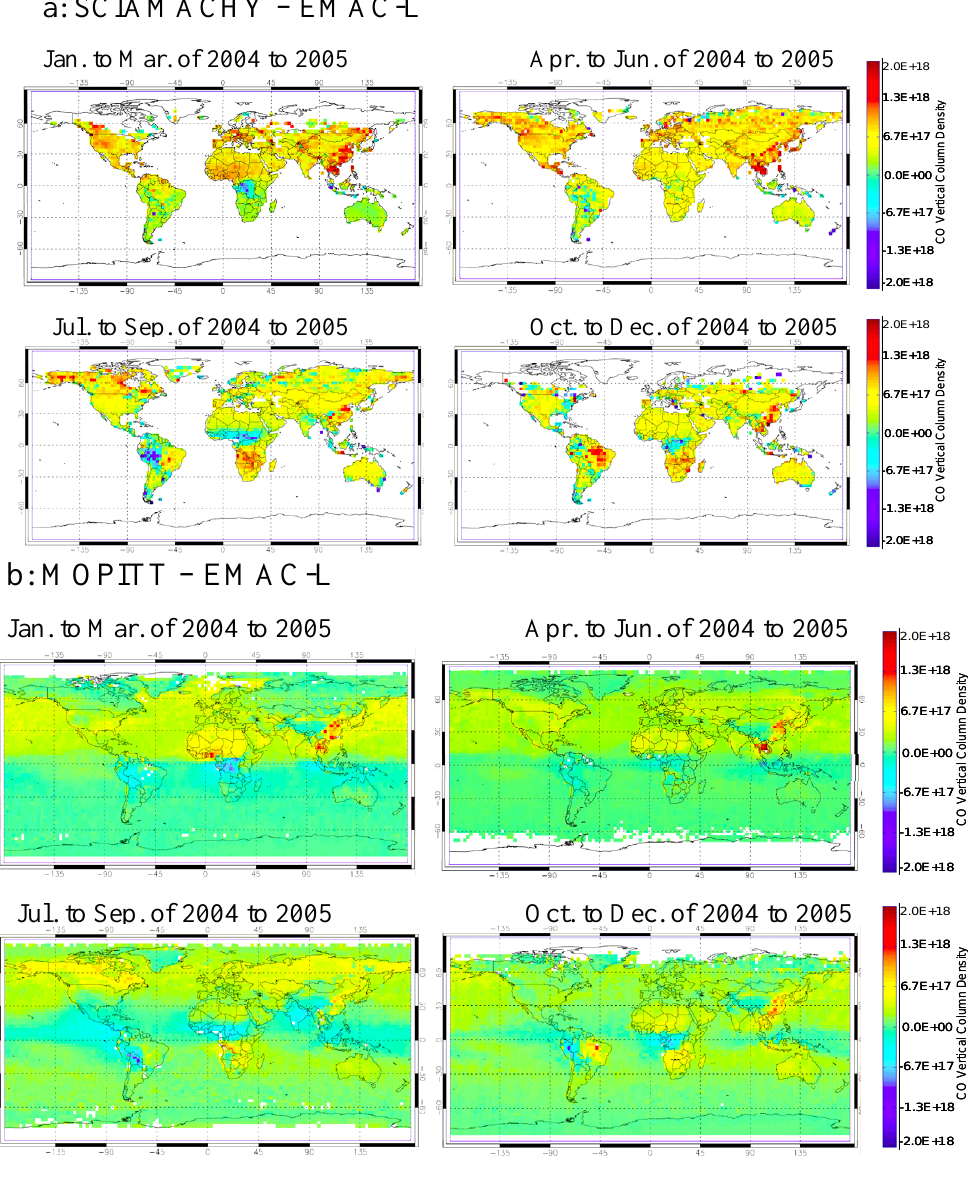
Fig. 14. Spatial distribution of averaged seasonal differences between satellite measurements (SCIAMACHY and MOPITT) and model (MATCH, EMAC, and GEOS-Chem) results of the CO VCD. EMAC-L refers to low (T42) and EMAC-H to high (T106) spatial resolution. Only coincident measurements were considered, and the height dependence of the measurement sensitivities was taken into account. White areas indicate missing